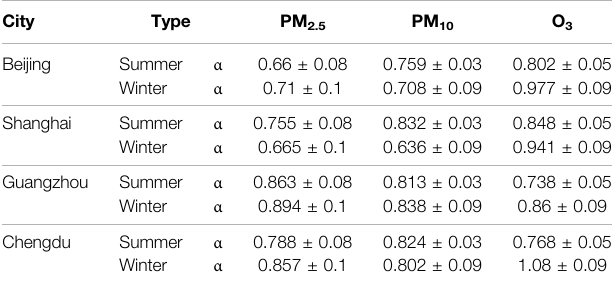
TABLE 2 | The DFA scale index α of PM 2.5 , PM 10 , and O 3 for Beijing, Shanghai, Guangzhou, and Chengdu in summer and winter